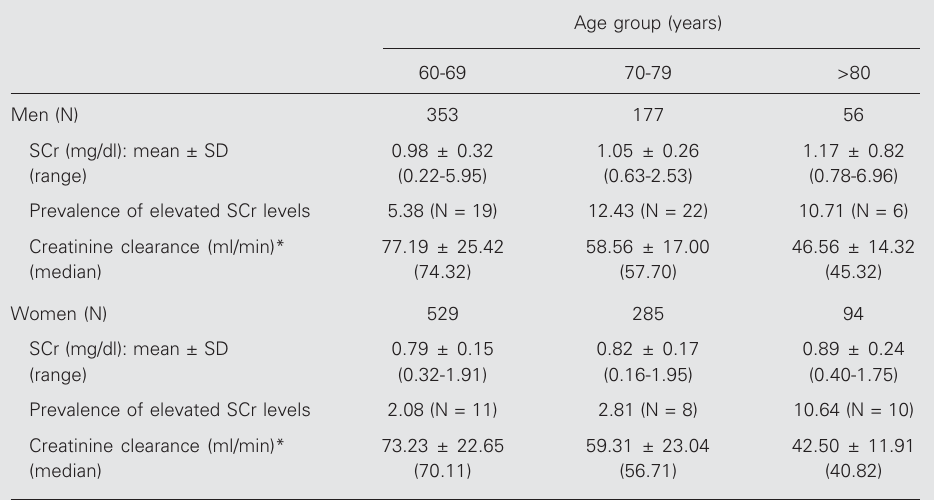
Table 2. Serum creatinine (SCr) and estimated creatinine clearance values by age and sex (Bambuí Health and Ageing